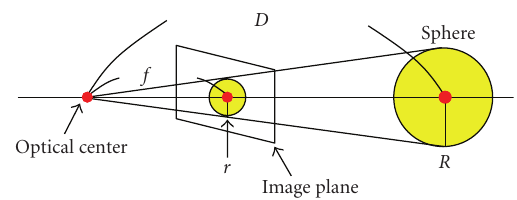
Figure 17: Accuracy of ball positions. Table 2: Estimated results